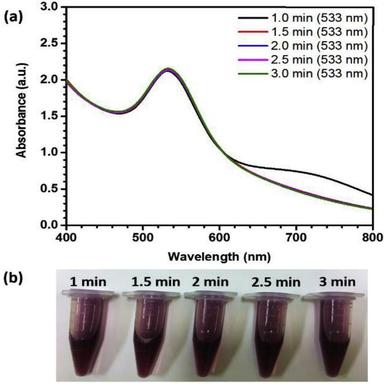
(a) UV–vis spectra of AuNPs synthesized using Lonicera japonica flower extract at varying reaction incubation time (1, 1.5, 2, 2.5, and 3 min) and (b) color changes after 2 min reaction incubation (from left to right: 1, 1.5, 2, 2.5, and 3 min). (For interpretation of the references to color in this figure legend, the reader is referred to the Web version of this article.)